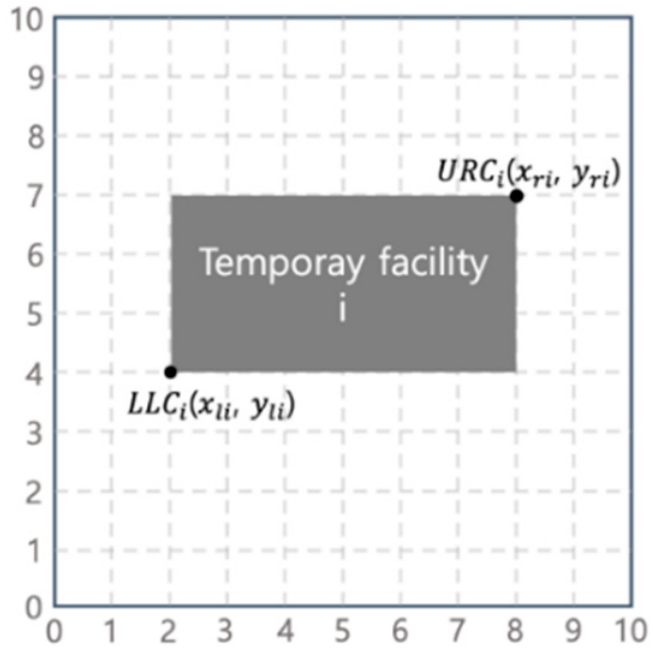
Figure 4. Representation of grid cells and temporary facilities on site.